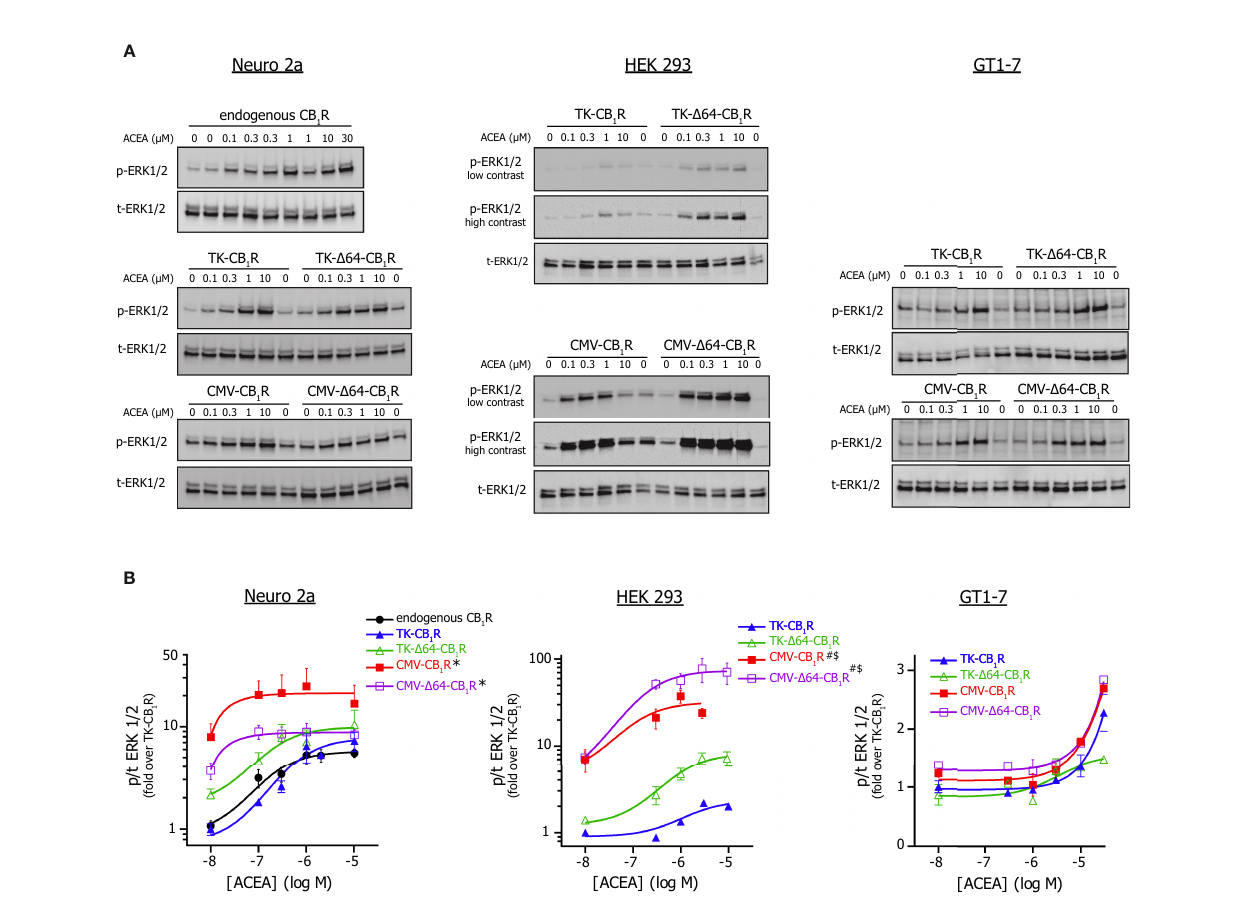
FIGURE 2 | ERK 1/2 activation by CMV or TK promoter-driven full-length and D 64-CB 1 receptor variants. (A) Western blot analysis of ERK 1/2 phosphorylation mediated by the various CMV and TK promoter-driven or endogenous CB 1 receptors stimulated with ACEA. Neuro 2a, HEK 293 and GT1-7 cells expressing the indicated CB 1 R variants or endogenous receptors (Neuro 2a) were stimulated with various concentrations of ACEA in at 37°C in DMEM + HEPES for 5 min. Representative western blots are shown; please note that, although presented as separate blots, p-ERK and t-ERK membranes were actually developed under identical conditions (incl. exposure times) so these images may be directly compared within the pertinent cell type. (B) Dose-response analysis of ACEA-evoked p- ERK 1/2 signals from western blot experiments as the one presented on Panel (A) . Phospho- to total ERK 1/2 values were normalized to the minimum response of the TK-CB 1 R group and the 3-parametered log[agonist] – response equation was used to fi t concentration-response curves. Number of observations was 3-8/ construct/ACEA concentration; *p = 0.036 for the effect of CMV promoter on basal ERK activity and p = 0.19 for the effect of CMV promoter on EC 50 when compared to TK promoter in Neuro 2a cells; # p = 0.0002 for the effect of CMV promoter on basal phosphorylation and $ p = 0.0288 for the effect of CMV promoter on EC 50 value vs. TK promoter in HEK 293 cells (2-way